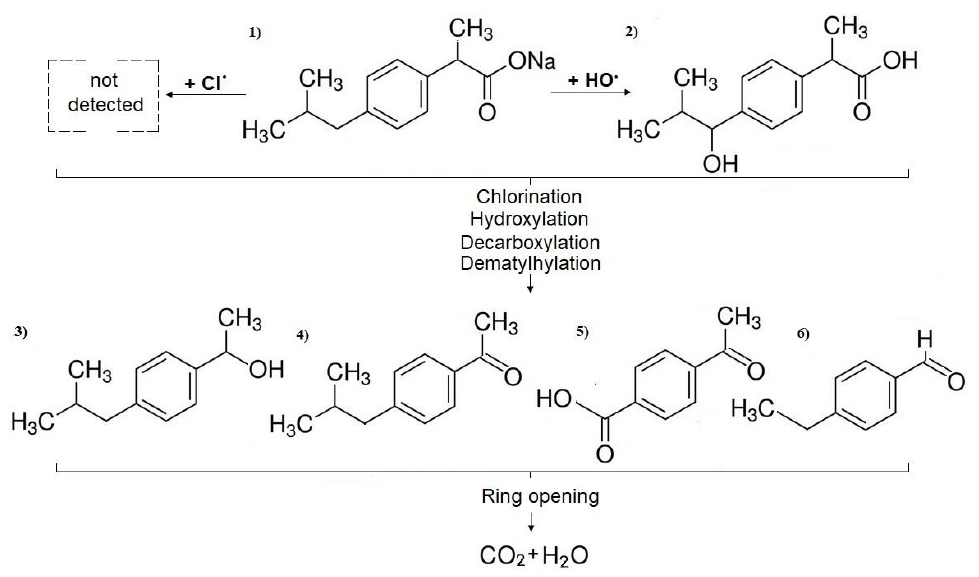
Figure 5. Possible decomposition of ( 1 ) IBU with the identified intermediates ( 2 ) 1-Hydroxyibuprofen, ( 3 ) 1-(4-Isobutylphenyl)ethanol, ( 4 ) 4’-Isobutylacetophenone, ( 5 ) 4-Acetylbenzoic acid, and ( 6 ) 4-Ethylbenzaldehyde.